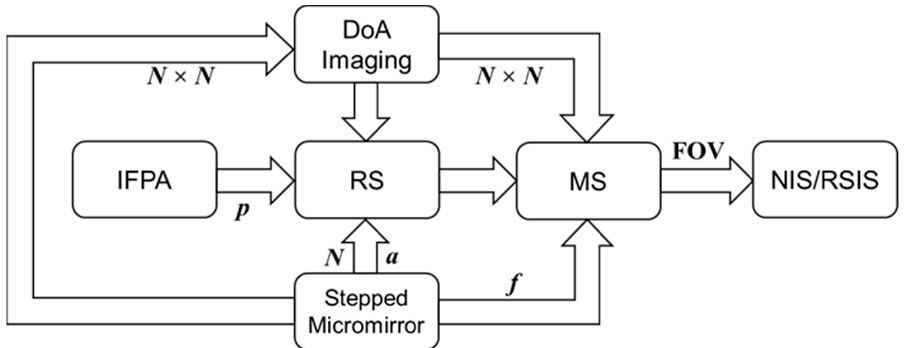
Figure 4. Design framework for the optical design of the SIIFTS; N represents the stepped micro ‐ mirrors’ maximum order; p represents a single pixel’s size of the IFPA; a represents a single step’s width, the f represents the focal length, FOV represents the field of view.